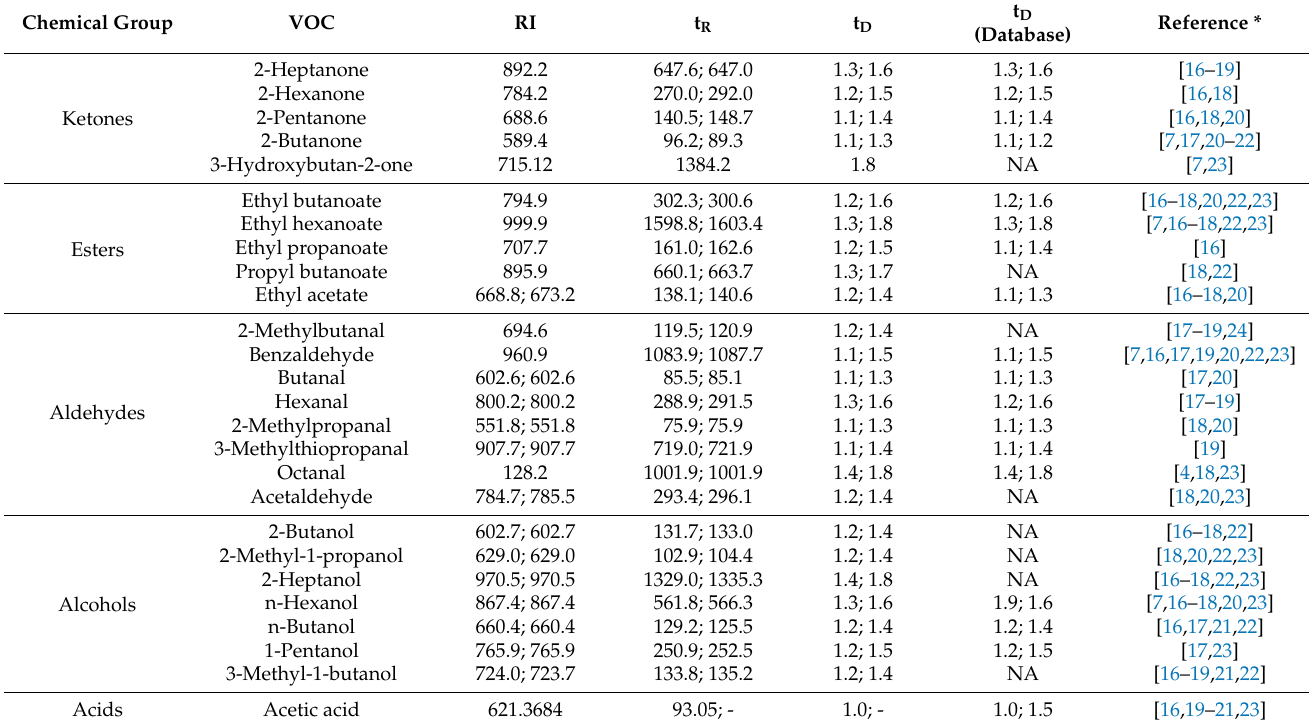
Table 1. Reference compounds of selected cheeses for analysis of LAB samples and raw sheep milk